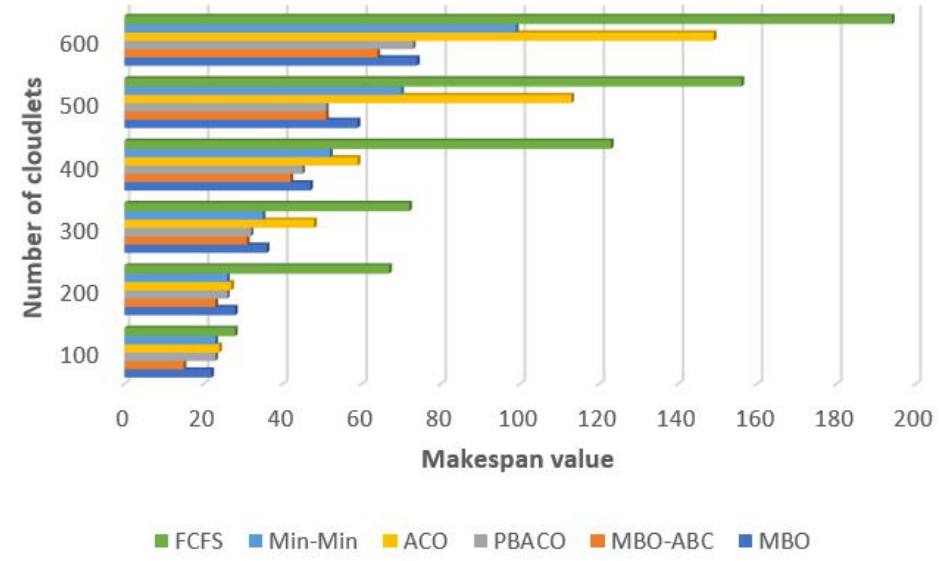
Figure 11. Comparative analysis—MBO-ABC vs. other approaches at arrival rate of 10 cloudlets per second with an artificial data set.